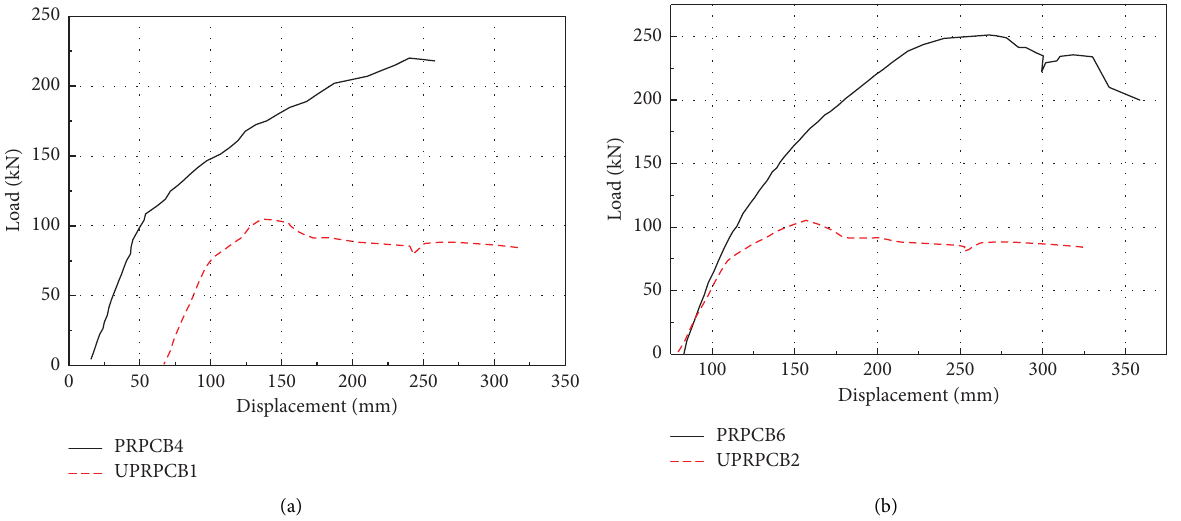
Figure 18: The effect of bonding on the midspan deformation of the specimens. (a) PRPCB4 and PRPCB2. (b) PRPCB5 and